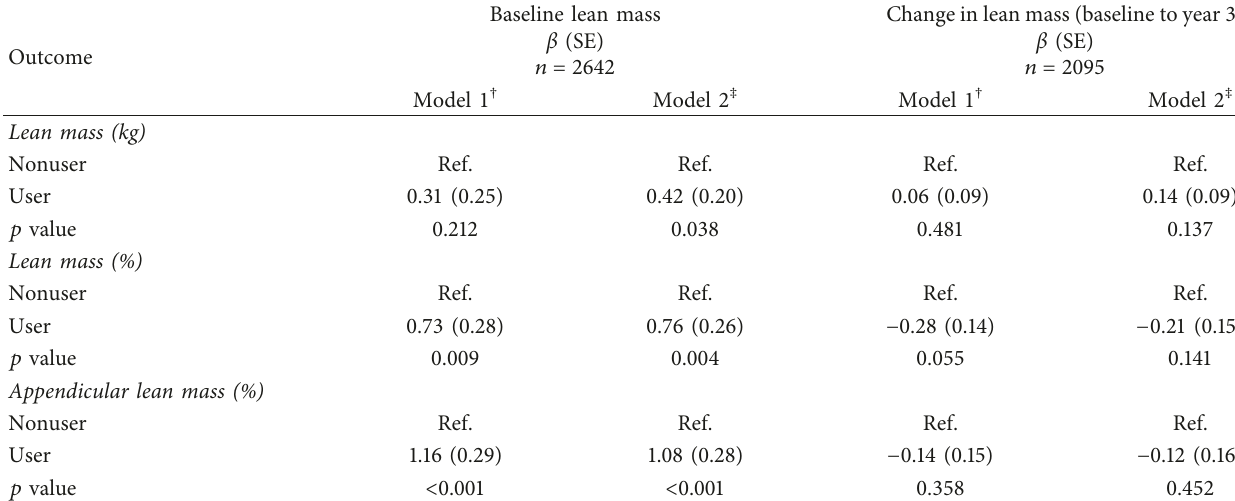
Table 2: Association between baseline ACE-I/ARB use and measures of lean mass using linear regression in hypertensive women from the Women’s Health Initiative ∗